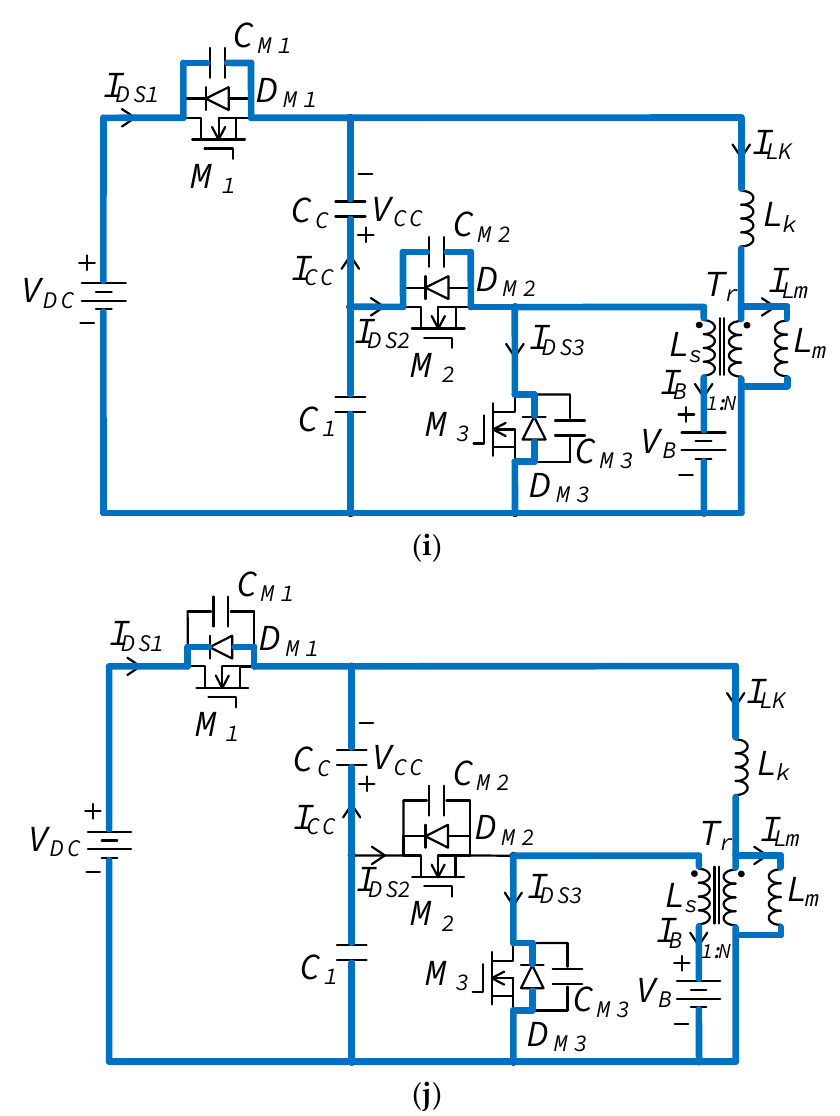
Figure 9. Equivalent circuit of each operational mode of the proposed hybrid converter operated in the utility line source condition over a complete switching cycle. ( a ) Mode1 ( t 0 ≤ t ≤ t 1 ), ( b ) Mode2 ( t 1 ≤ t ≤ t 2 ), ( c ) Mode3 ( t 2 ≤ t ≤ t 3 ), ( d ) Mode4 ( t 3 ≤ t ≤ t 4 ), ( e ) Mode5 ( t 4 ≤ t ≤ t 5 ), ( f ) Mode6 ( t 5 ≤ t ≤ t 6 ), ( g )